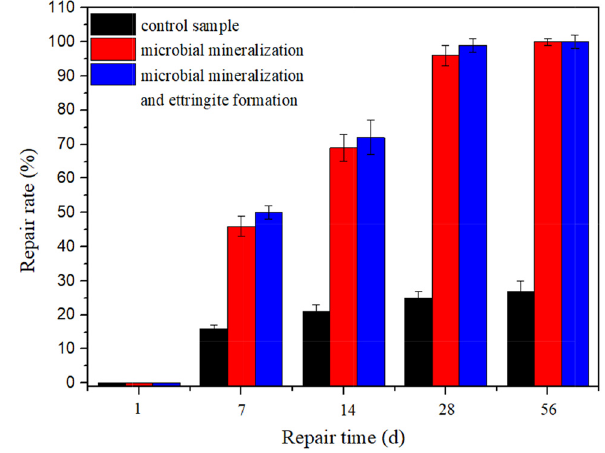
Figure 10: The water permeability resistance repair rate of the whole crack at di ff erent